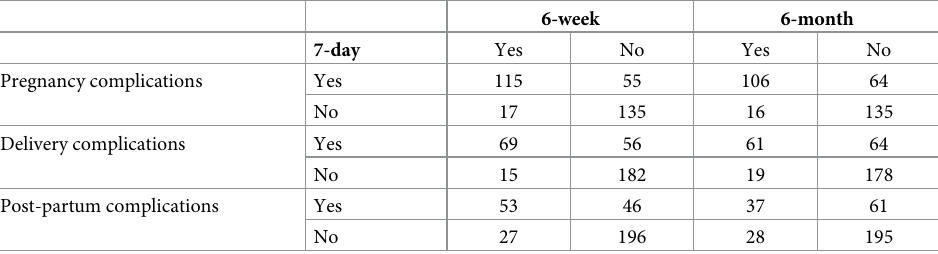
Table 3. Frequency of reporting of any maternal complications during frequency, delivery, and post-partum between 7-day and 6-week and 6-month interview.